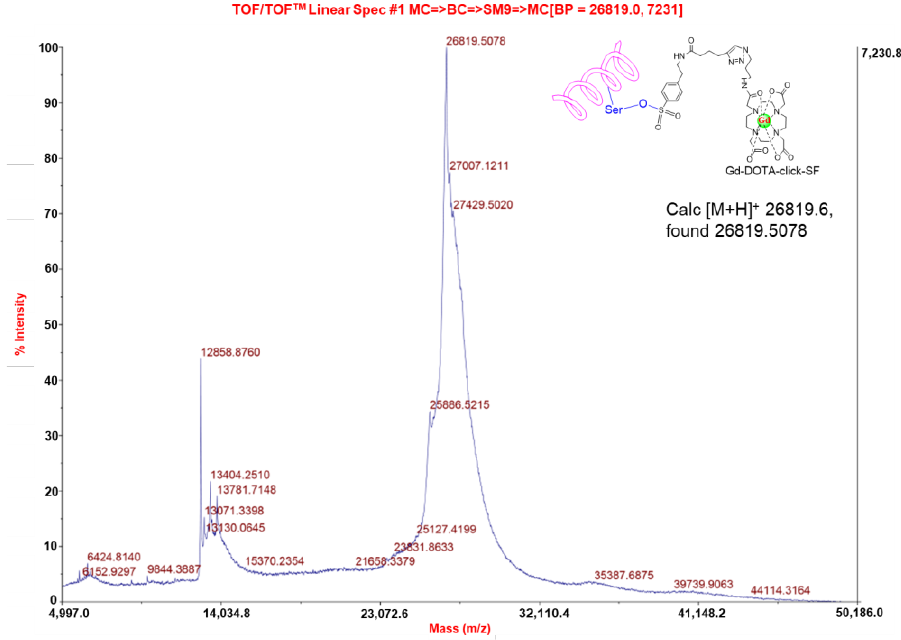
Figure 6. MALDI-TOF/TOF mass spectrum of Gd-DOTA-click-elastase (linear mode)